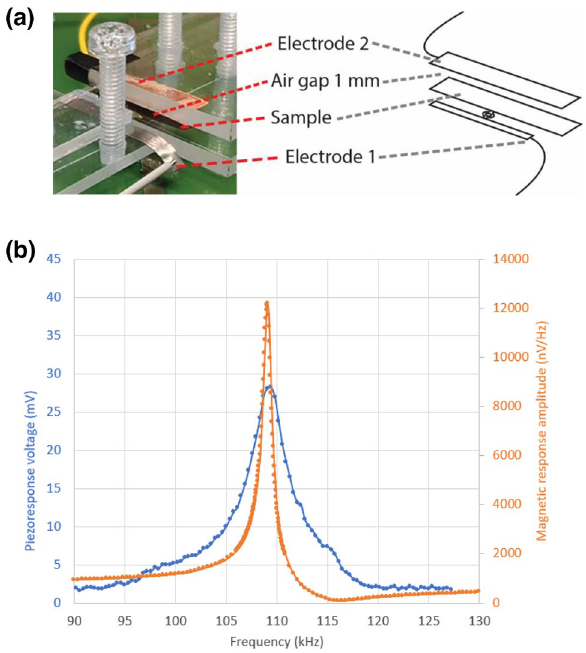
Figure 3. Non-contact measurement of the ME coupling. ( a ) Sample with schematic showing the airgap between the sample and electrode 2. ( b ) Piezoelectric peak-to-peak voltage (blue) and magnetic amplitude signal response (orange) versus frequency of the magnetic field excitation. The cables to the amplifier are connected to the clamped part of the Metglas film [electrode 1 in ( a )] and to the non-contact electrode (with an area equal to the PEDOT:PSS area), at a distance 1 mm above the PEDOT:PSS layer (utilizing the capacitive coupling between PEDOT:PSS and